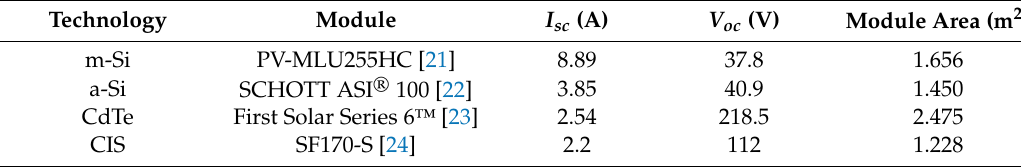
Table 3. Specifications of m-Si, a-Si, CdTe, and copper indium selenide (CIS) modules. Technology